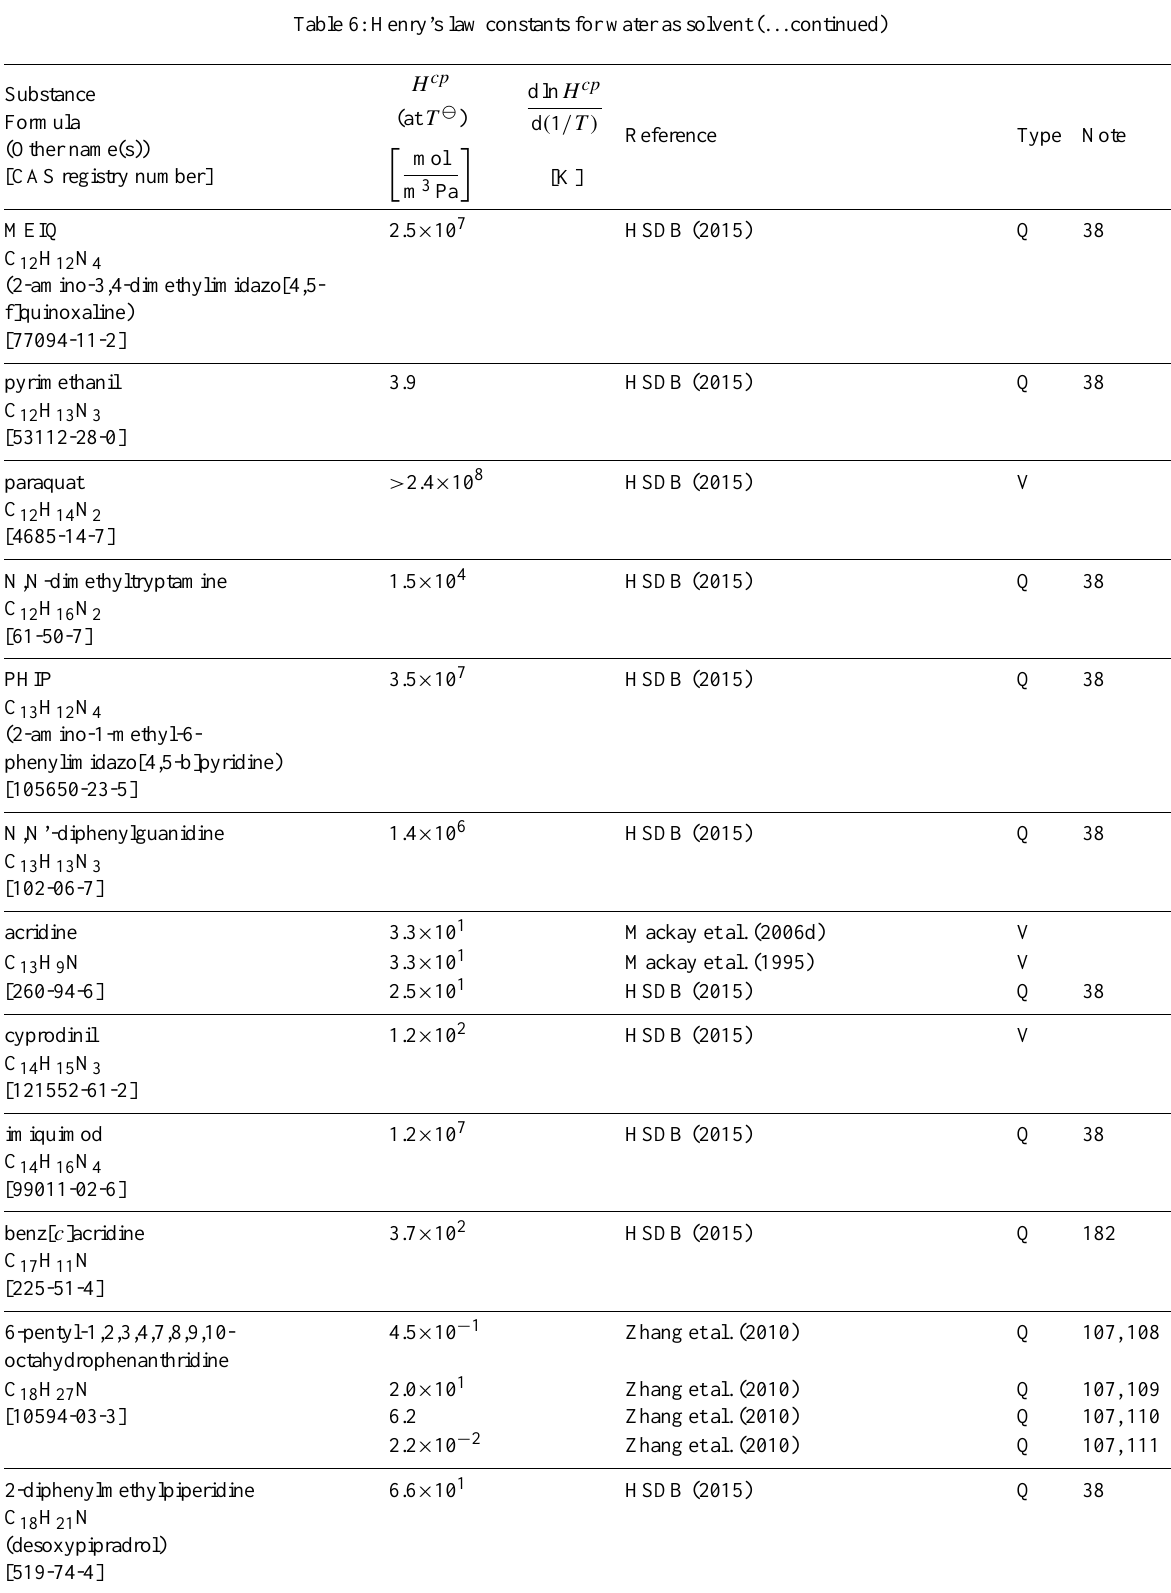
Table 6: Henry’s law constants for water as solvent